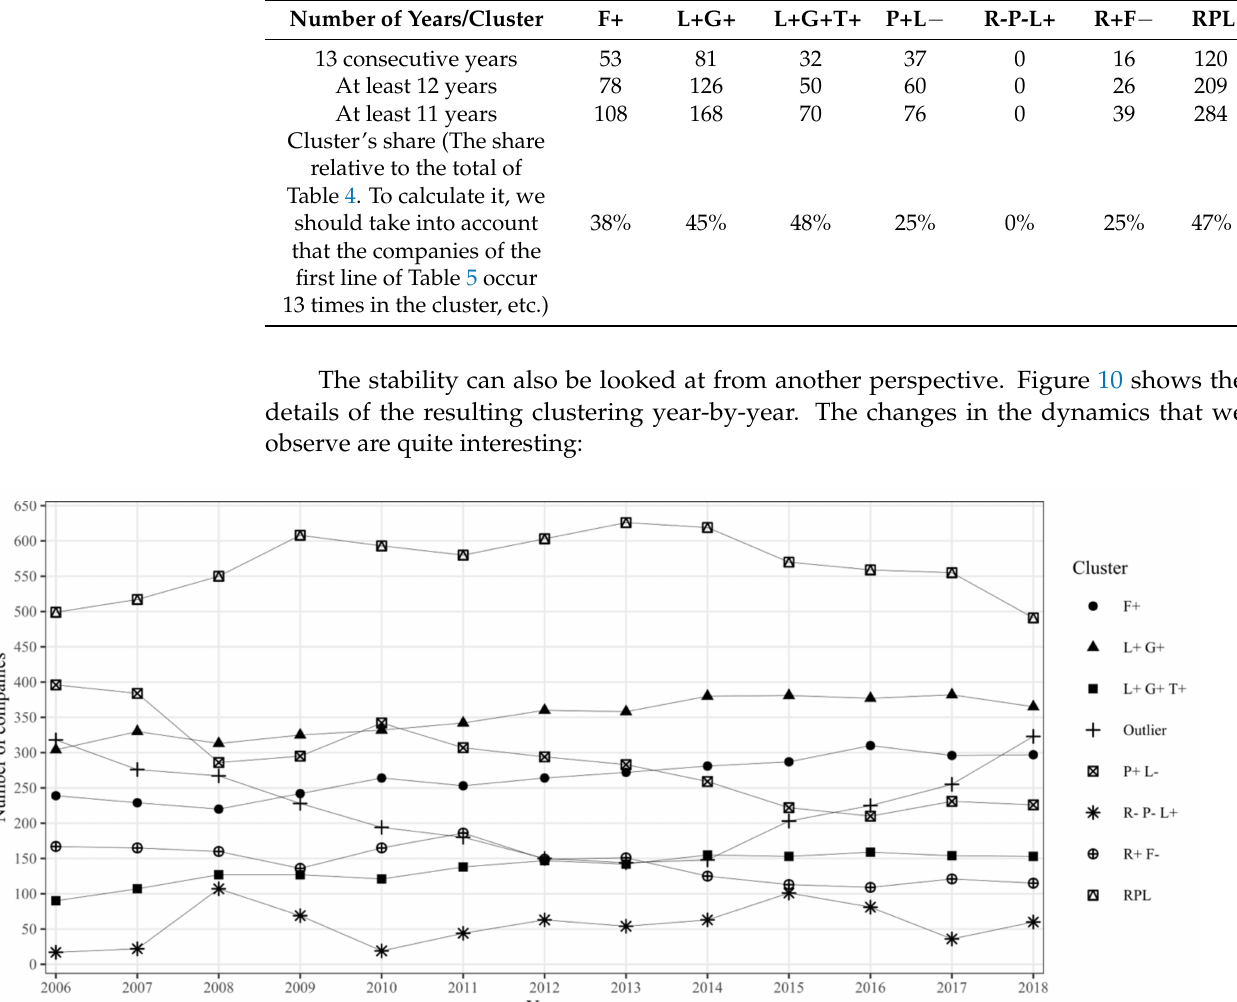
Table 5. Number of companies that were in a particular cluster for a certain number of years between 2006 and 2018.